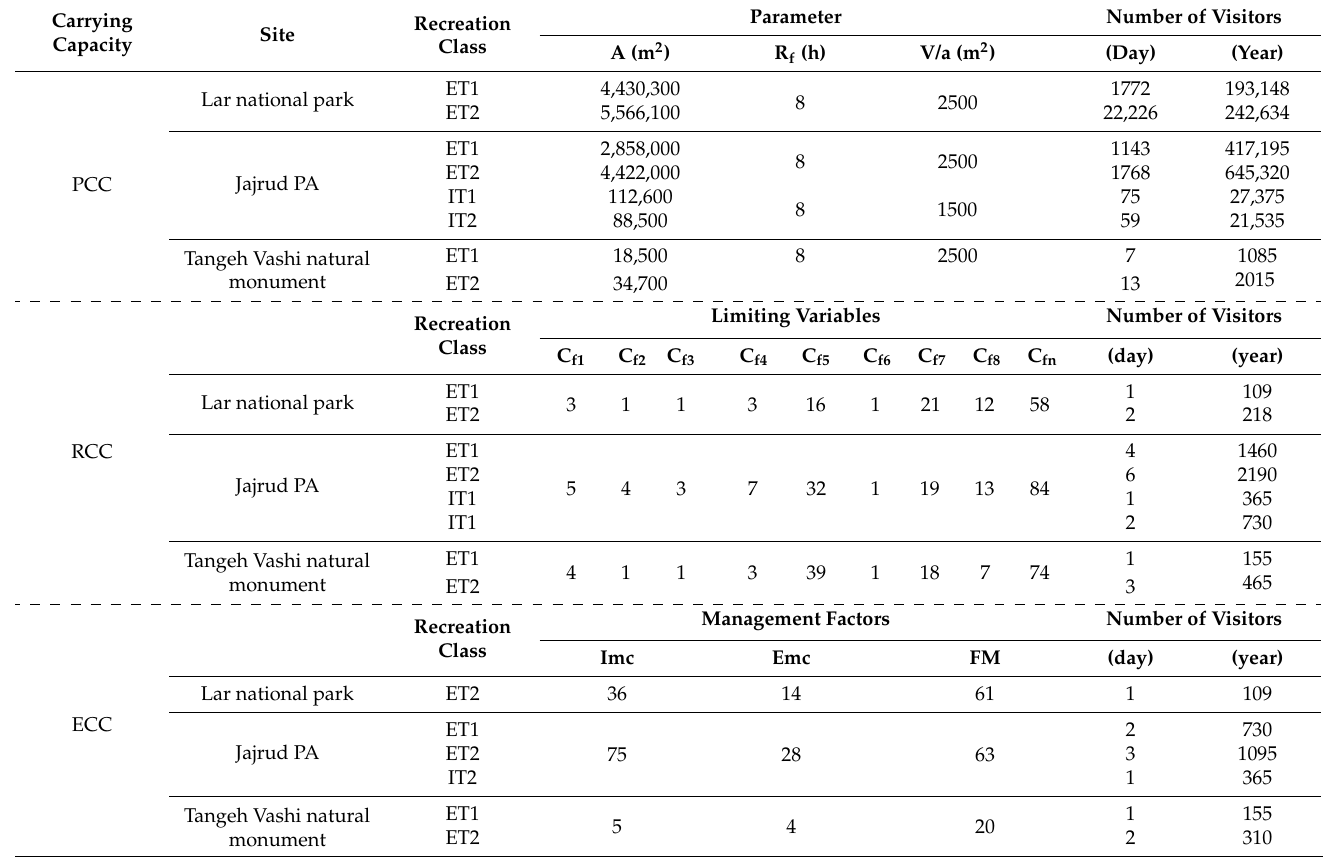
Table 5. Estimation of the physical carrying capacity (PCC), real carrying capacity (RCC), and effective carrying capacity (ECC) for the studied